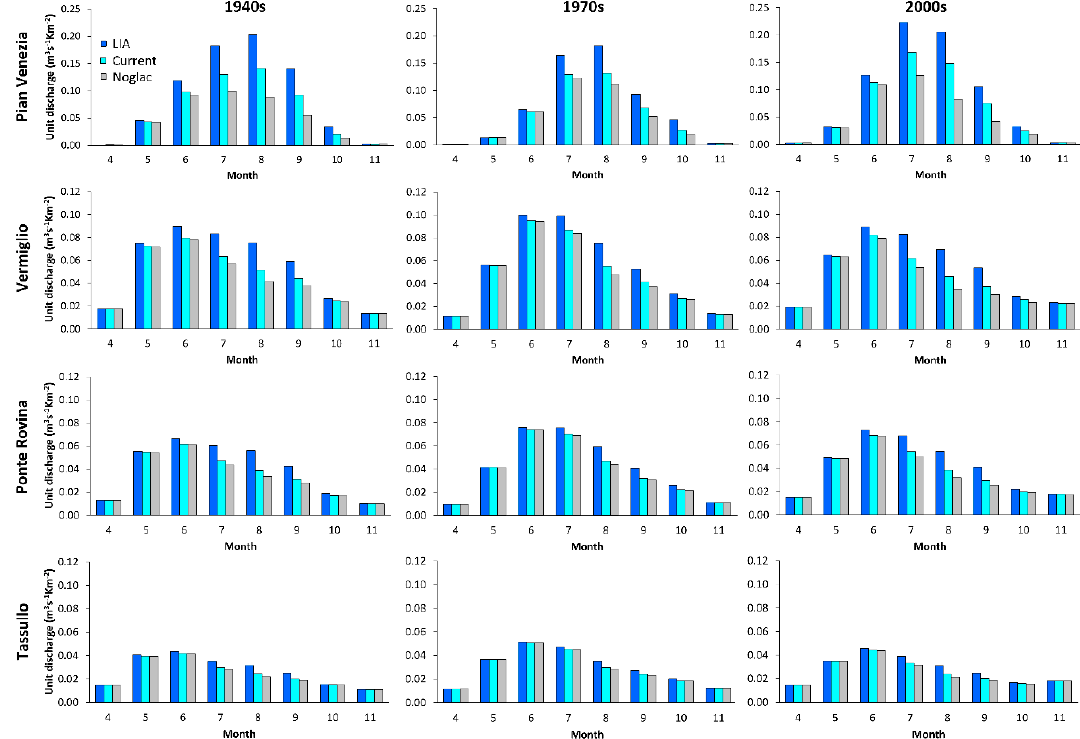
Figure 5. Monthly unit discharge calculated in the four catchments (rows) and in different meteorological periods (columns) with three different glacier extents (colors). Please, note that the vertical axis at Pian Venezia is different from the other three catchments.